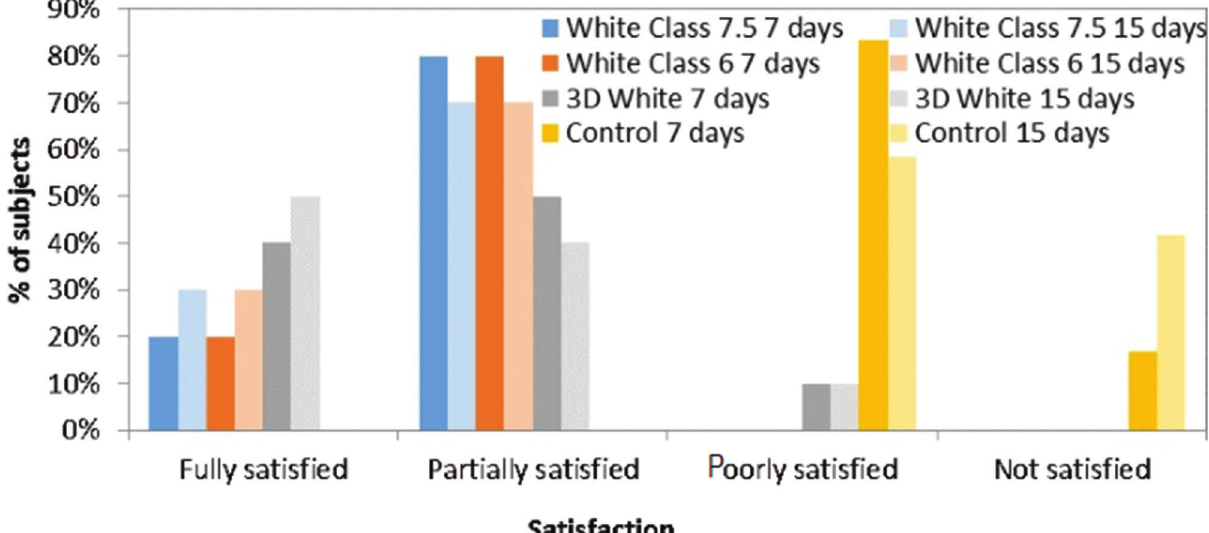
Figure 6 - Subjects ’ overall perception of satisfaction with the color.